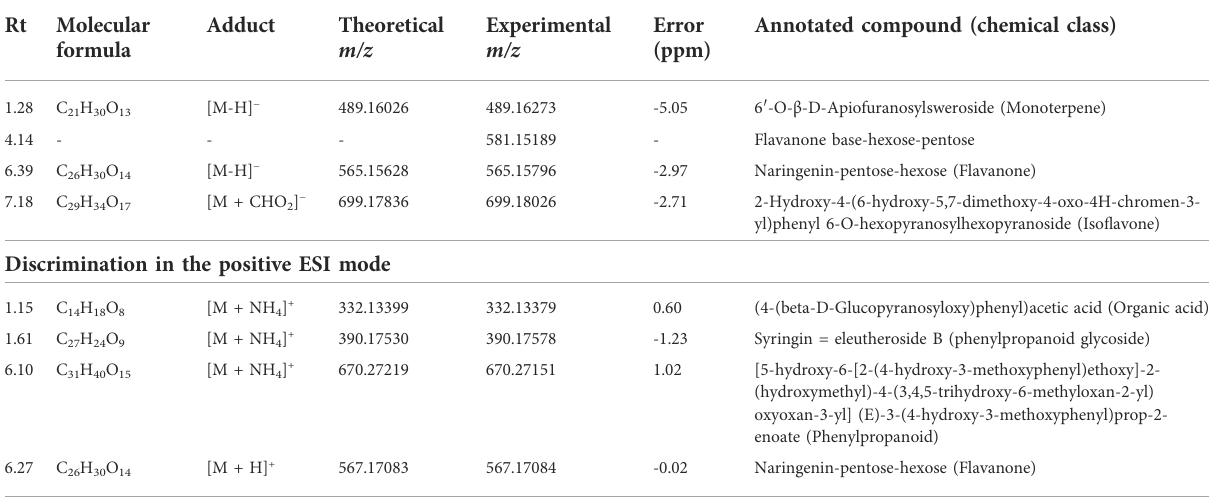
TABLE 1 Annotated VIP responsible for Viscum album host tree discrimination in negative and positive ionization modes. Discrimination in the negative ESI mode Rt Molecular Adduct Theoretical Experimental Error Annotated compound (chemical m/z m/z formula (ppm)